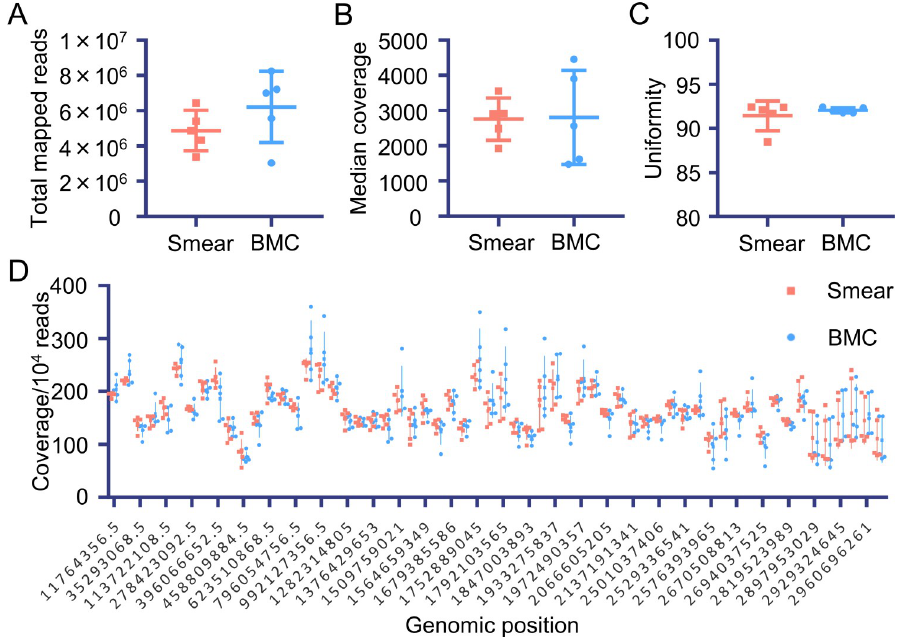
Fig 2. Read and coverage analysis of target sequence data derived from the smear and BMC samples. The following values were compared between the smear and BMC samples: (A) total mapped reads, (B) median coverage depth, (C) uniformity (more than 20% median coverage), and (D) normalized coverage for each amplicon region.